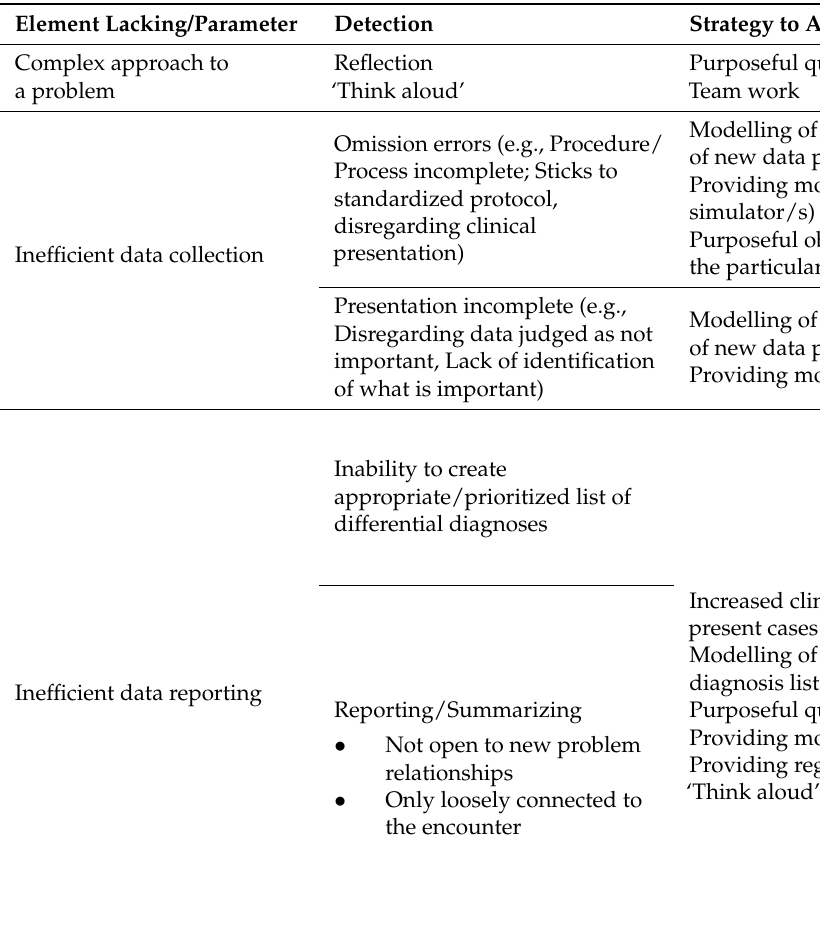
Table 1. Addressing common elements of inadequate problem-solving by veterinary